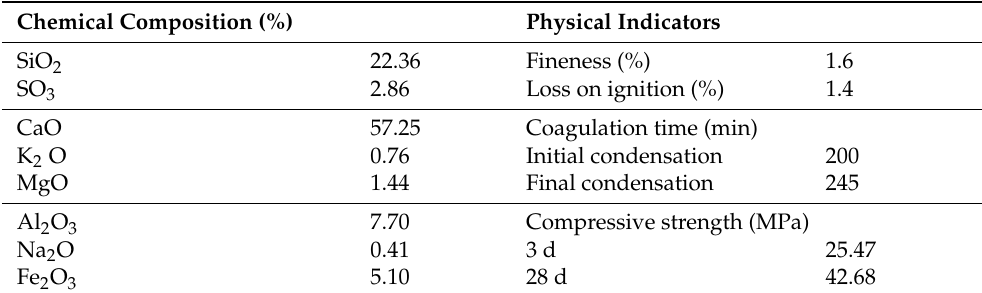
Table 1. Chemical composition and physical indicators of cement. Chemical Composition